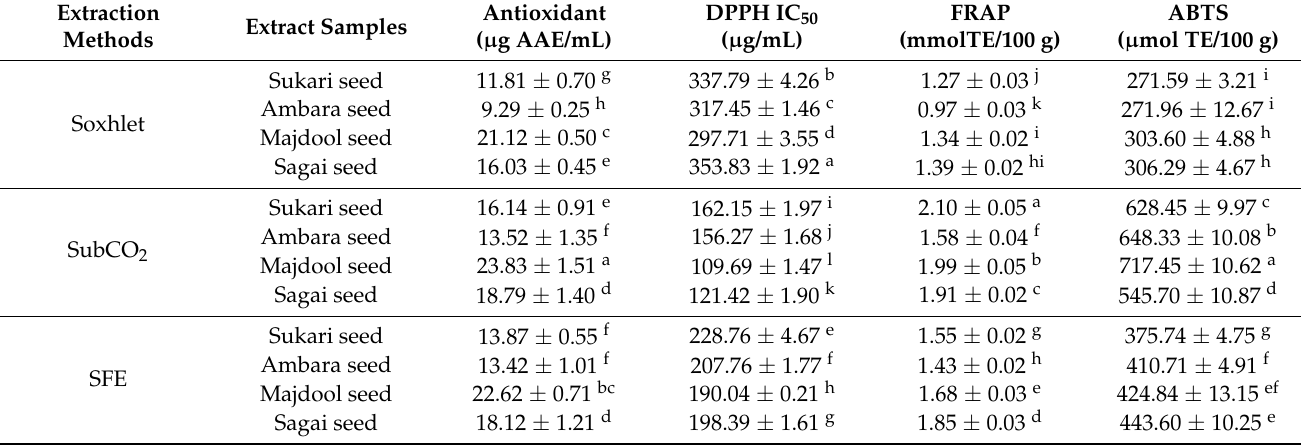
Table 4. Antioxidant/biological properties of date seed extracts obtained by using different extraction